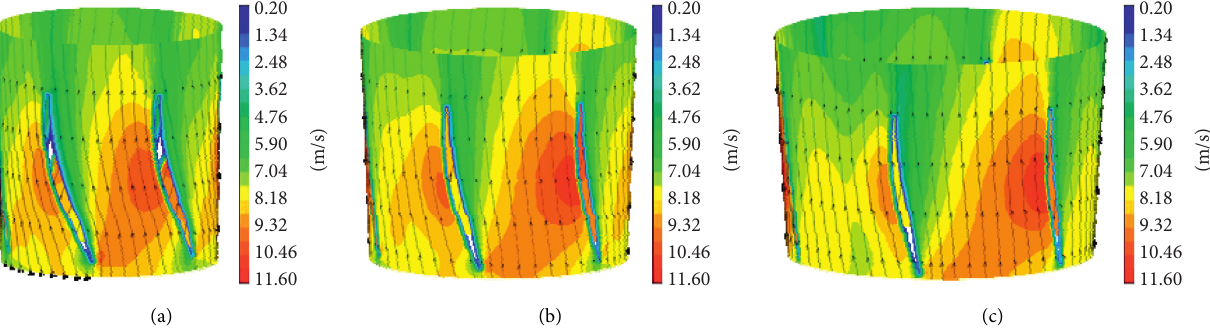
Figure 14: Flow fields of the three tori of the guide vane ( Δ β � − 10 ° ). (a) Inner torus. (b) Middle torus. (c) Outer